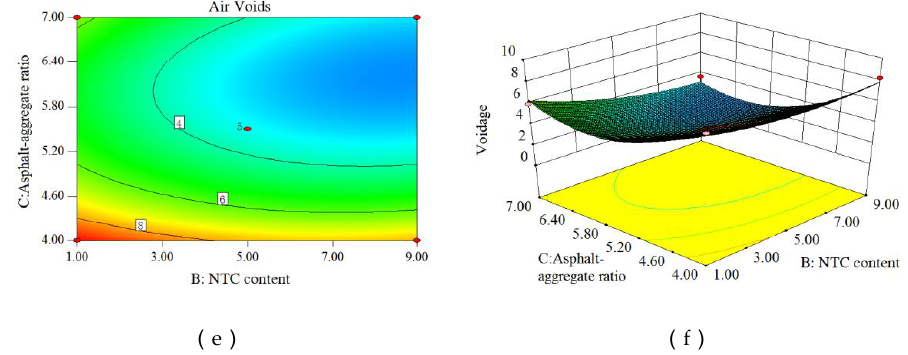
Figure 6. Contour maps and response surface maps of the air voids and influencing factors. ( a ) Contour map between basalt fiber content, NTC content and air voids; ( b ) Three-dimensional surface graph between basalt fiber content, NTC content and air voids: ( c ) Contour map between basalt fiber content, asphalt–aggregate ratio and air voids; ( d ) Three-dimensional surface graph between basalt fiber content,